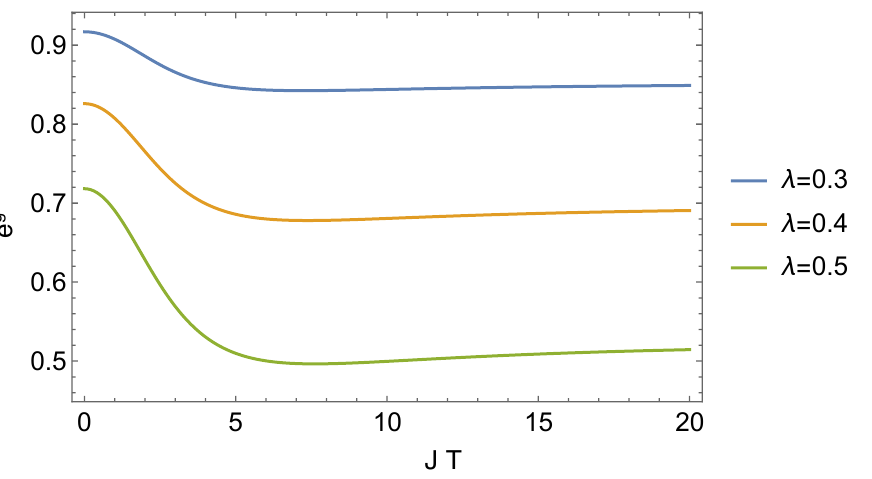
Figure 9 . γ 2 = γ ∗ as a function of J T for β J = 100 . On the left, λ = 0 . 9 , whereas on the right 1 λ = 0 . Solid lines are obtained by numerically solving equation (3.32). The dashed lines are the “pinching” approximation derived in (3.35). At large β J , pinching is a reasonable approximation even when 1 − λ 2 is not small (left).